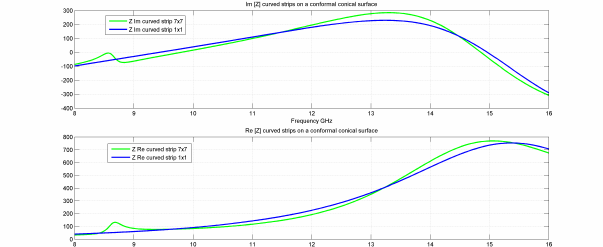
Fig. 6. Curved wire (left panel) and array of 7x7 curved elements (the central one is fed) (right panel) Fig. 7 shows the behavior of the antenna impedance of both the isolated and the wire surrounded by the passive ones in the frequency range 8-16 GHz.